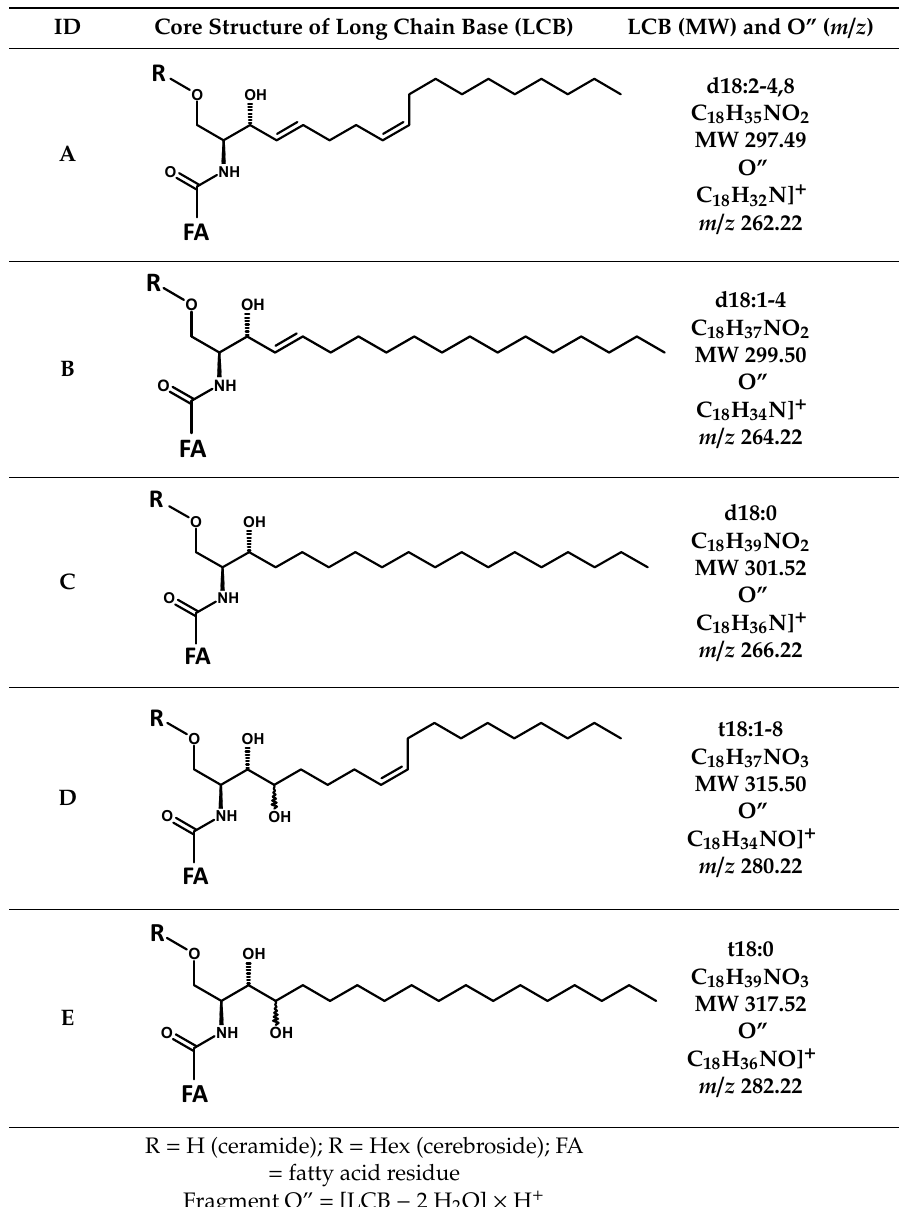
Table 1. Structures of the screened long chain bases and of the corresponding reporter ion fragments. ID